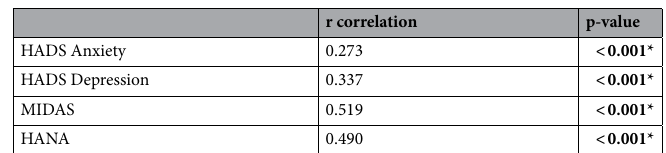
Table 4. Partial correlation between the number of HD and healthcare utilization, mental health and disability. *Controlling by age, gender, education level, smoking, alcohol, BMI and health insurance coverage.